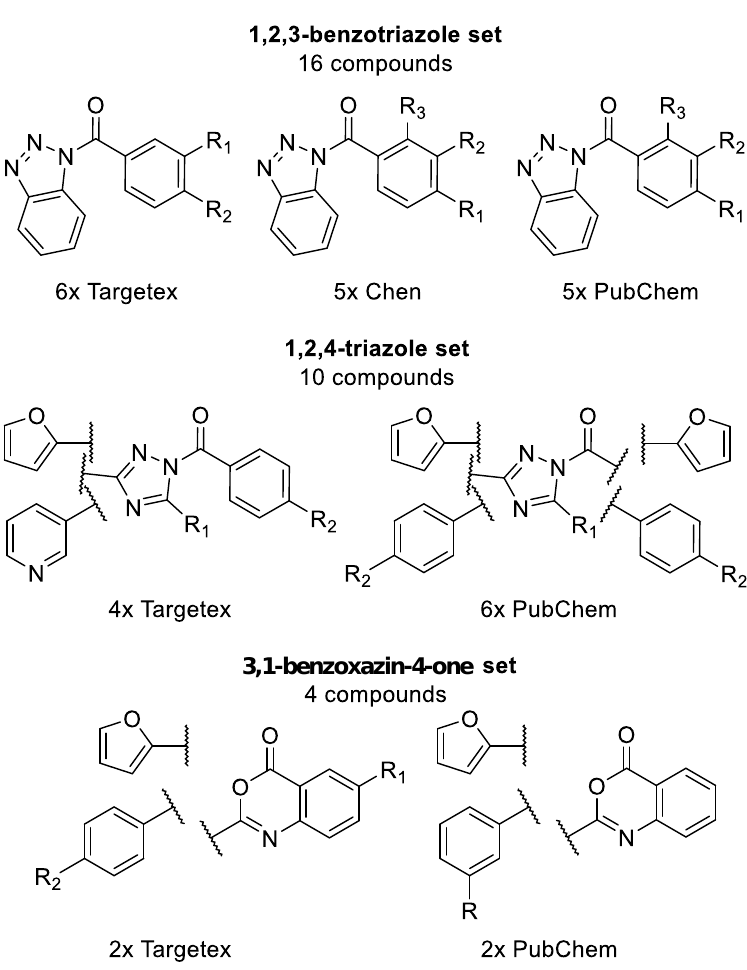
Figure 2. The selected 1,2,3-benzotriazole model (AARR_3). One of the aromatic groups (R8) and the two acceptor groups (A1 and A4) groups are planar while the plane of the second aromatic group (R7) is slightly bent.